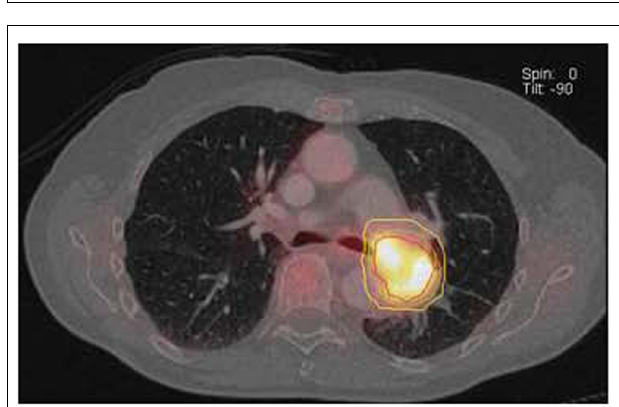
FIGURE 7 |A centrally located left upper lobe tumor. F18 FDG PET/CT shows large FDG avid mass without mediastinal metastases. Integrated contrast CT defines the relationship of tumor with adjacent aorta and pulmonary vessels. Automated 3D contouring of metabolically avid tumor was performed using a threshold of 40% of SUVmax.Volume of interest was exported as RT structure set for radiation planning.